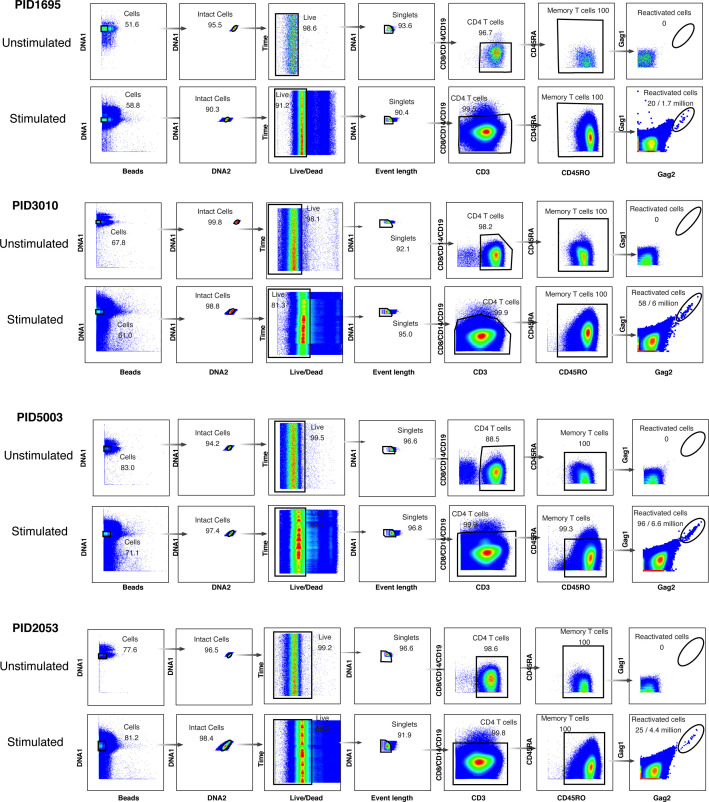
Gating strategy to identify ex vivo reactivated cells from four HIV-infected, ART-suppressed patients.Memory CD4+ T cells were purified by negative selection from leukapheresis specimens and then either left unstimulated and fixed immediately, or stimulated for 40 hr with PMA/ionomycin and then fixed. The unstimulated and stimulated specimens were then analyzed using CyTOF. Shown is the gating strategy leading to the identification of live, singlet memory CD4+ T cells expressing HIV Gag proteins as detected on two separate channels. These cells also bind to the third set of anti-Gag antibodies and exhibit downregulation of cell-surface CD4 (data not shown).